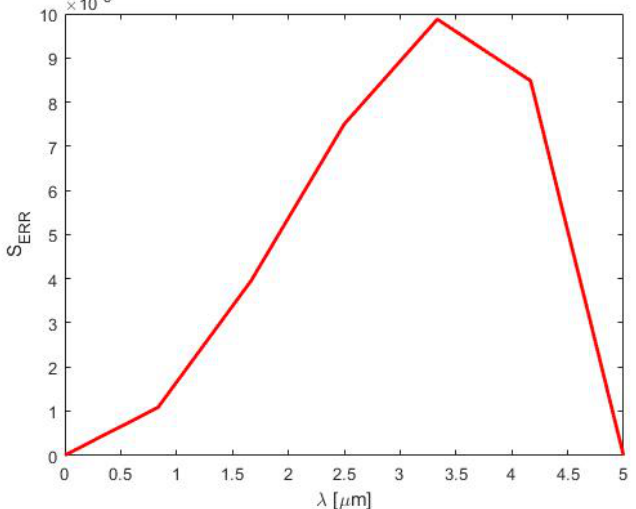
Figure A7. The difference between the spectral response with 1% error in the voltage and without it using Hermite